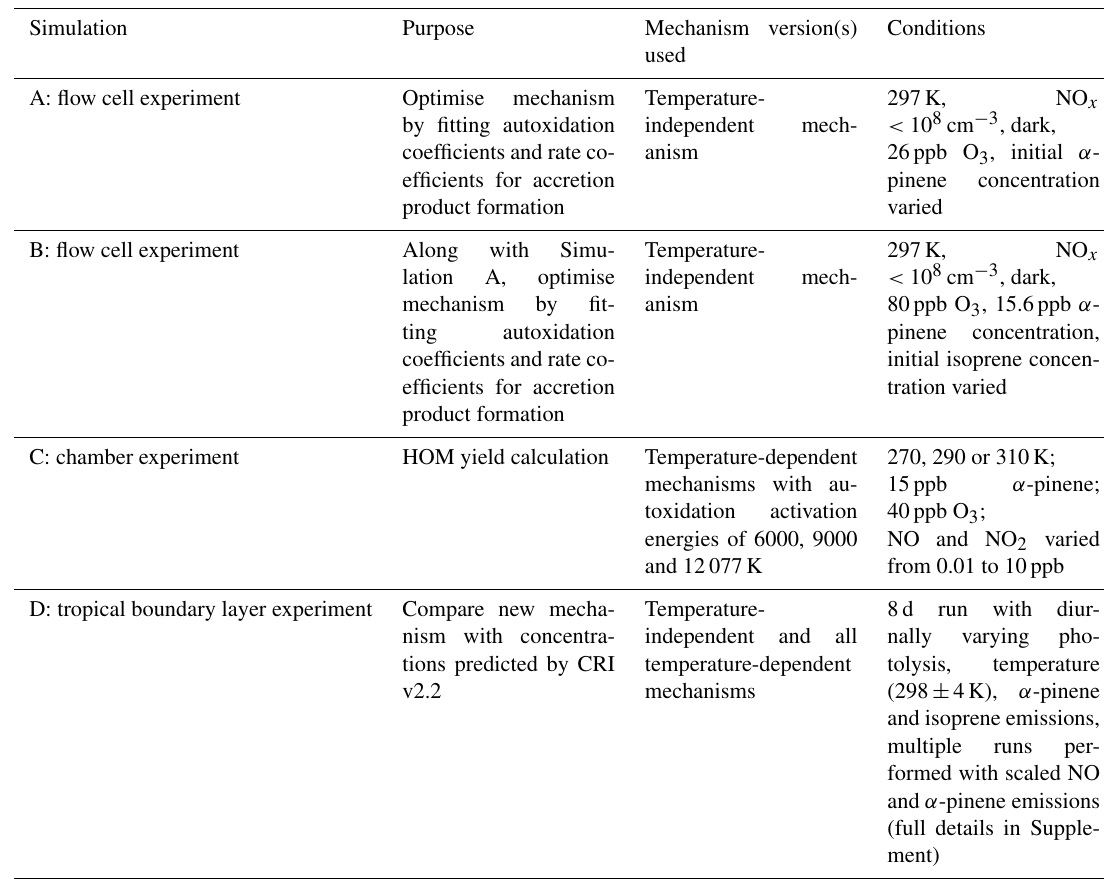
Table 3. Simulations used for developing and testing new